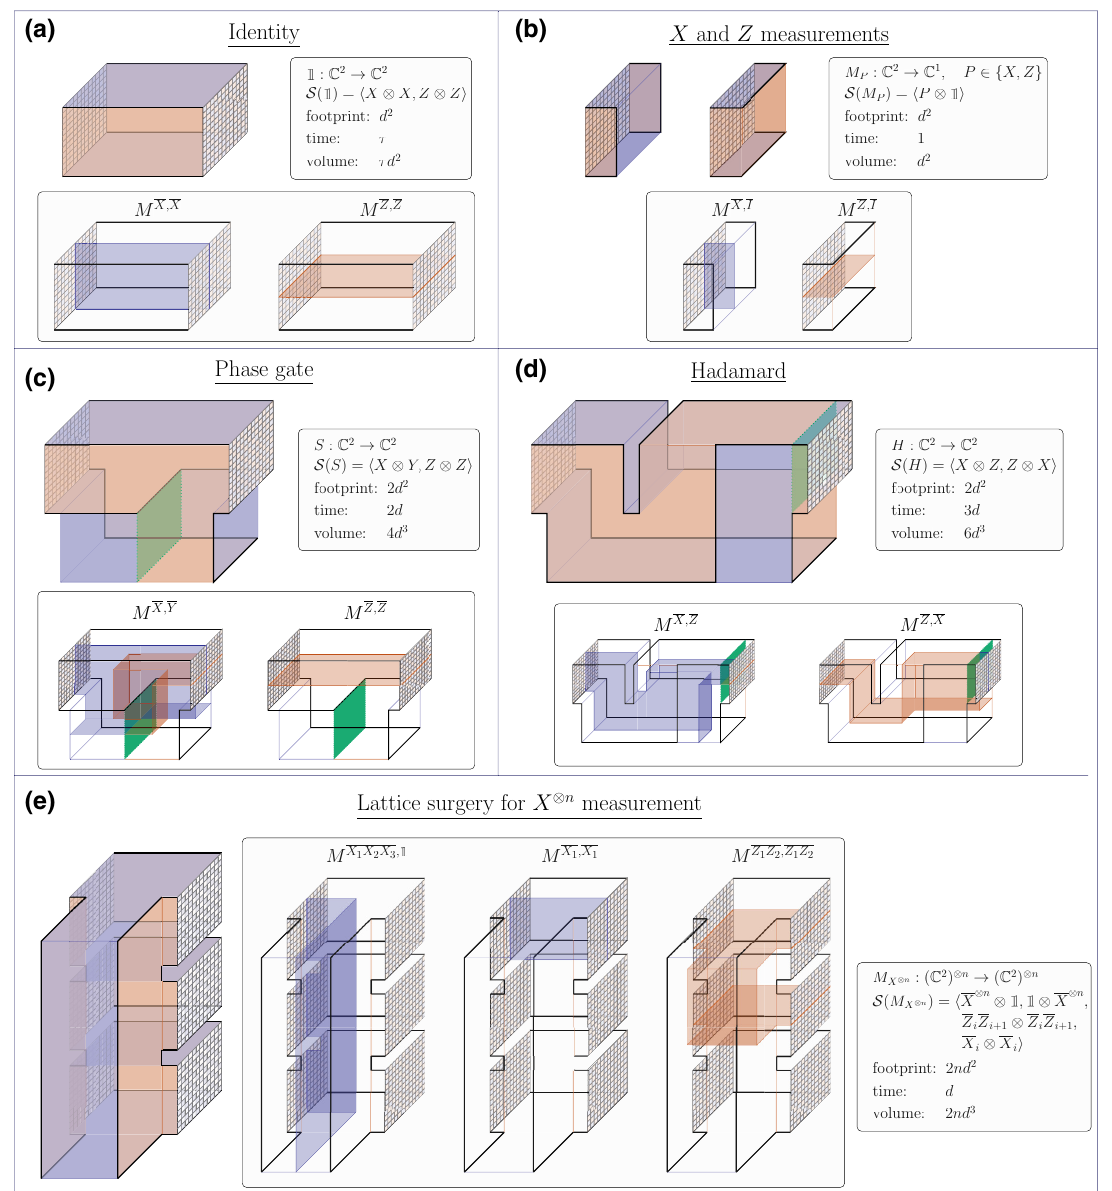
FIG. 6. Logical templates for Clifford operations. Primal and dual boundaries are depicted in blue and red, domain walls in green, cornerlines and twists in bold black. For each operation U , a membrane M P , Q is shown for each generating logical correlator P ⊗ Q ∈ S ( U ) . Time and footprint overheads are based on traversing the block from left to right in 2D slices; however, we emphasize that networks of such operations may be traversed in any direction. (a) The identity gate for time τ . (b) Measurements of Pauli X and Z amount to placing a primal or dual boundary and can be done in constant time; the measurement outcome is inferred from the logical membrane terminating on the boundary. Preparations are given by the respective time-reversed template. (c) The phase gate can be realized by the braiding of two cornerlines. One of the cornerlines is propagated as a twist through the bulk, while the other moves around the exterior of the block. (d) The Hadamard can be realized by a clockwise or counterclockwise rotation of the cornerlines. Note that the “trench” created by the dual boundary may be as thin as a width-0 plane (meaning that the boundaries on either side coincide). (e) Lattice surgery to measure X ⊗ n can be realized by fusing together cornerlines from different logical qubits. The outcome ⊗ n , 1 membrane terminating on the of the logical measurement is inferred from the M X